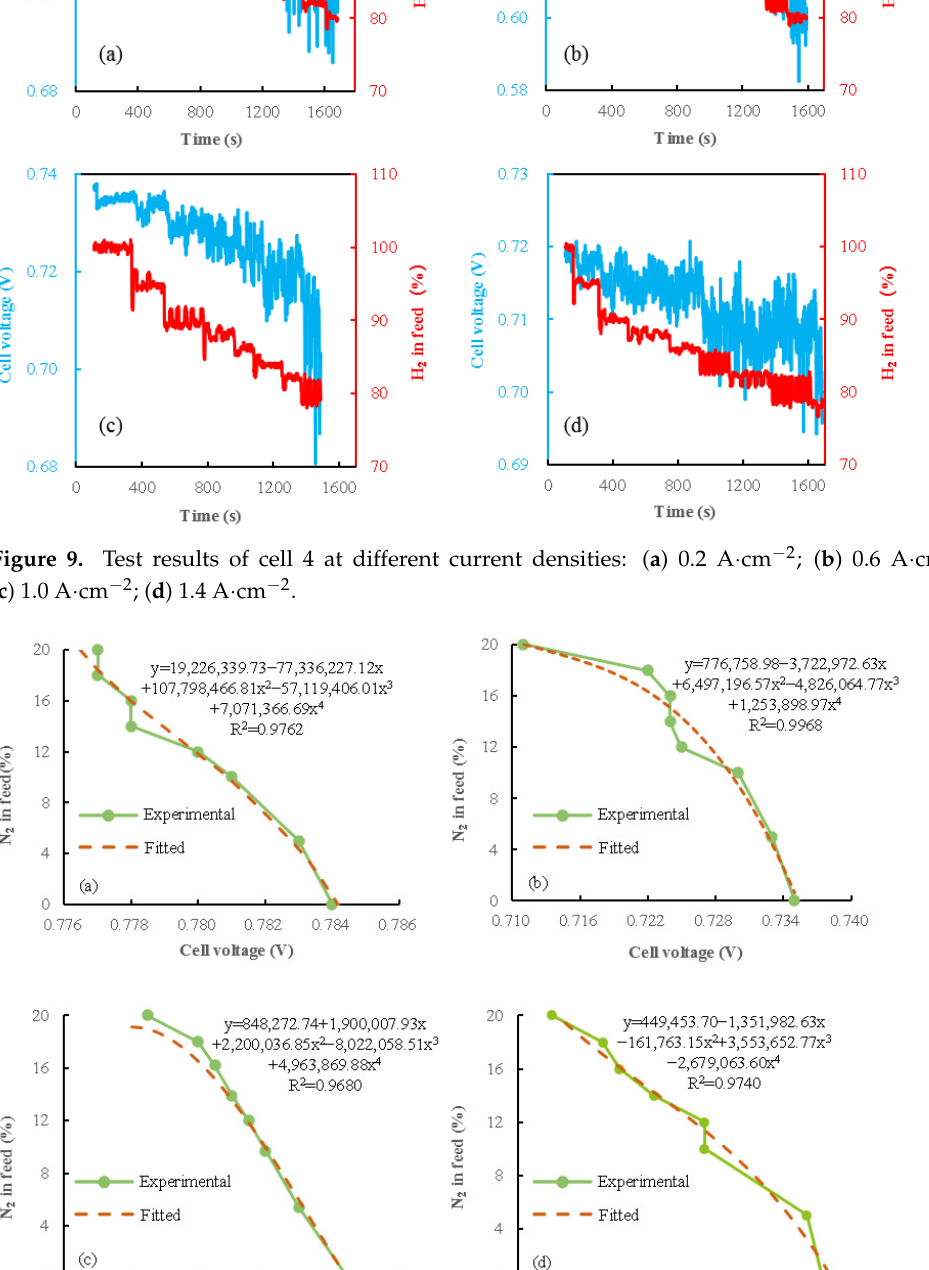
Figure 10. Fitting results of cell 4 at different current densities: ( a ) 0.2 A · cm − 2 ; ( b ) 0.6 A · cm − 2